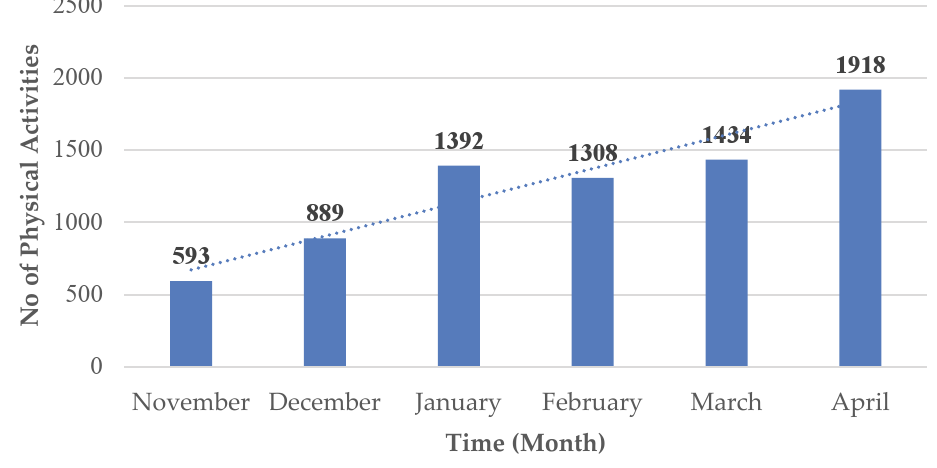
Figure 1. Distribution of the total number of physical activities /month.